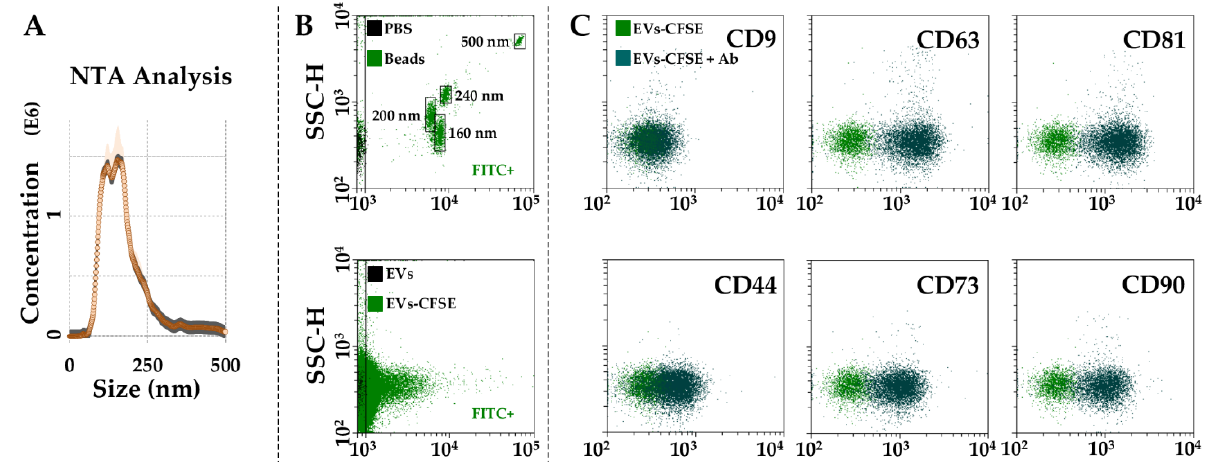
Figure 5. Characterization of BMSC-EVs. ( A ), EVs size analysis from NTA data. ( B ), flow cytometer was first calibrated to score FITC-fluorescent particles of nanometer scale (upper panel, starting from 160 nm). EVs were then CFSE stained to allow their identification and gating in the FITC channel (lower panel). ( C ), after gating, CFSE + EVs showed positive staining for CD63 and CD81 extracellular vesicle defining molecules and CD44, CD73 and CD90 MSC markers. CD9, another EV postulated marker, was barely detectable. Representative cytograms are presented.